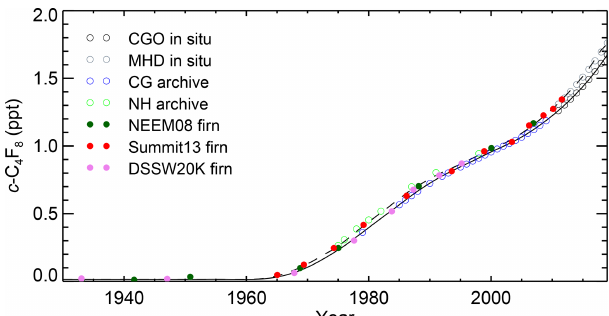
Figure 3. Historic atmospheric c -C 4 F 8 mole fractions reconstructed for the extratropical Northern Hemisphere and Southern Hemi- sphere from air extracted from polar firn (full circles, NEEM08 in dark green, Summit13 in red, DSSW20K in pink, against mean or effective ages; SPO01 with mean age of ∼ 1890 is not shown), an- nual values from spline fits to Cape Grim Air Archive (CG archive, open blue circles) and in situ measurements at Cape Grim (CGO, open black circles), archived air samples (NH archive, open green circles), and in situ measurements at Mace Head (MHD, open grey circles). Also shown are reconstructed abundances based on opti- mized emissions determined by the CSIRO inversion for the extrat- ropical SH (black line) and NH (dashed black